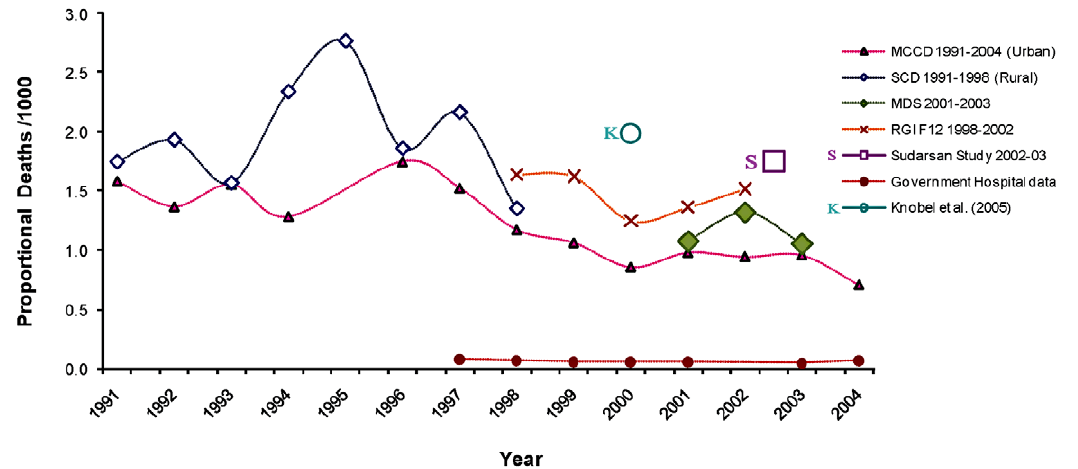
Figure 2. Proportional rabies mortality reported from various sources in India 1991–2005. We collected rabies deaths as reported from 6 different sources in India from 1991 to 2005 in order to compare our estimates with all other estimates available. (1) Medically Certified Causes of Death (MCCD) [28] data for 1991–2004 are mostly urban deaths collected from selected urban hospitals mainly from the 10 biggest states. (2) Survey of Cause of Death (SCD) [29] data are rural deaths between 1991–98 and were collected from about 1900 selected rural Primary Health Centers (PHC) in 23 states and 3 union territories. (3) Causes of Death Survey (Form 12) (RGI, 1998–2002) data are from the Registrar General of India. It shares the same sample framework (Sample Registration System) as our Million Death Study (MDS; 2001–2003) and includes both urban and rural deaths. (4) Sudarshan’s study (January 2002 to March 2003) [9] was a multi-centre community survey conducted by 23 university/research institutions in their territorial areas. (5) Government hospital data from the routine data collection of the Union Ministry of Health and Family Welfare [6]. These data were significantly under reported and produced very inconsistent and sporadic results. Therefore, to calculate proportional deaths, our denominator was all causes of deaths from the states where at least one rabies death had been reported. (6) Knobel et. al. [4] rabies deaths were calculated independently from a predictive probabilistic model based on hypothetical human-canine density, post-exposure treatment, and regional demographic features. The model does not consider any mortality statistics from